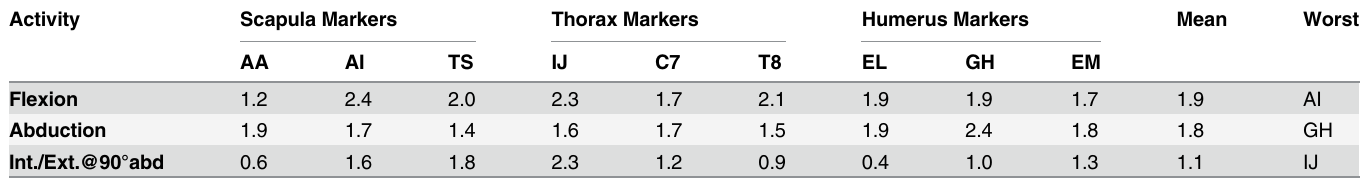
Table 2. Marker errors between model reconstruction and bone-pin experiments (RMS in mm) from three shoulder activities. The mean error across all markers and the worst marker for a task are also provided. Scapula markers include Angulus Acromialis (AA), Angulus Inferior (AI) and Trigonum Spinae (TS). Thorax markers include Incisura Jugularis (IJ), the spinous process of the seventh cervical (C7) and eighth thoracic (T8) vertebra. Humerus markers include the glenohumeral joint center (GH) and the lateral (EL) and medial (EM) epicondyles. Marker definitions from [18]. Activity